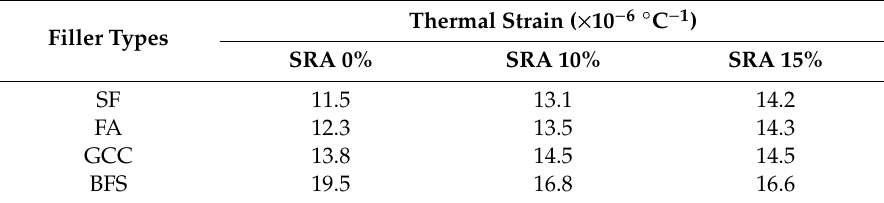
Table 9. Coe ffi cient of thermal expansion with SRA content and filler